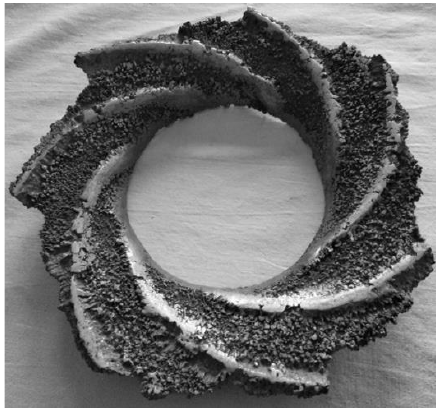
Fig. 4. Cavitation erosion [3]